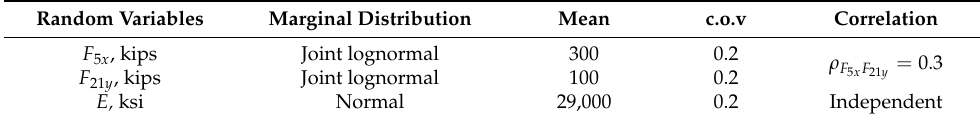
Table 13. Description of the random variables for the cantilever truss optimization problem.